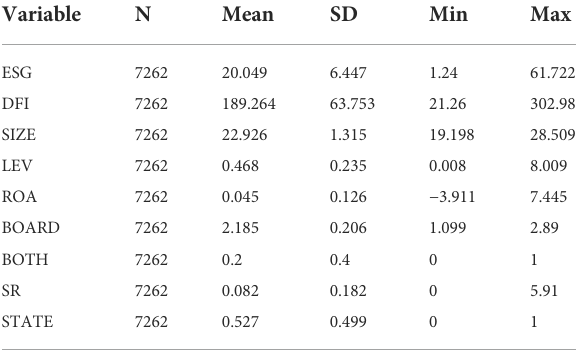
TABLE 2 Summary